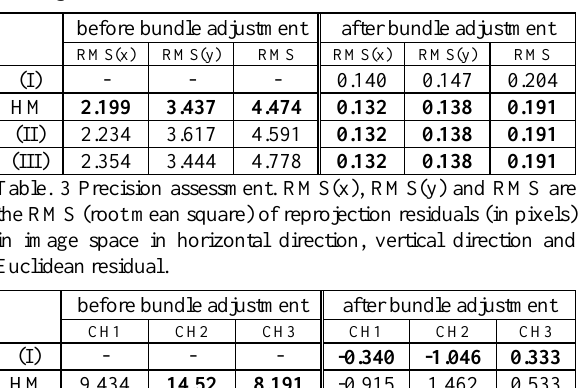
Figure. 8 Overall view of the simulated urban scenario.